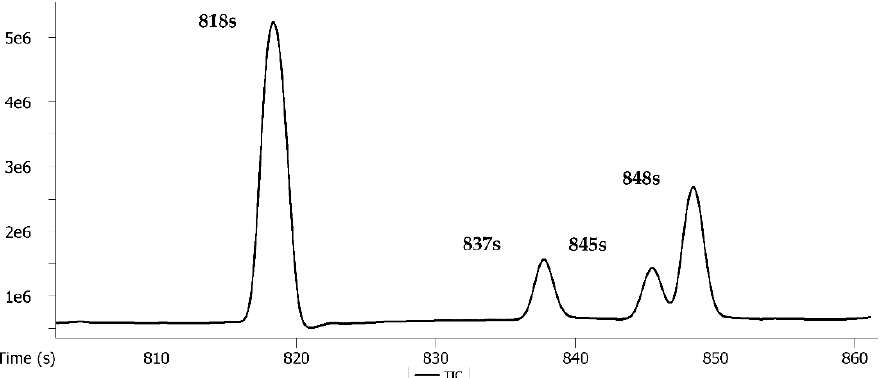
Figure 2. TIC chromatogram segment demonstrating four primary products of limonene aqueous chlorination. All four numbers shifted away from the tops of the corresponding peaks. I do not know how to place them correctly